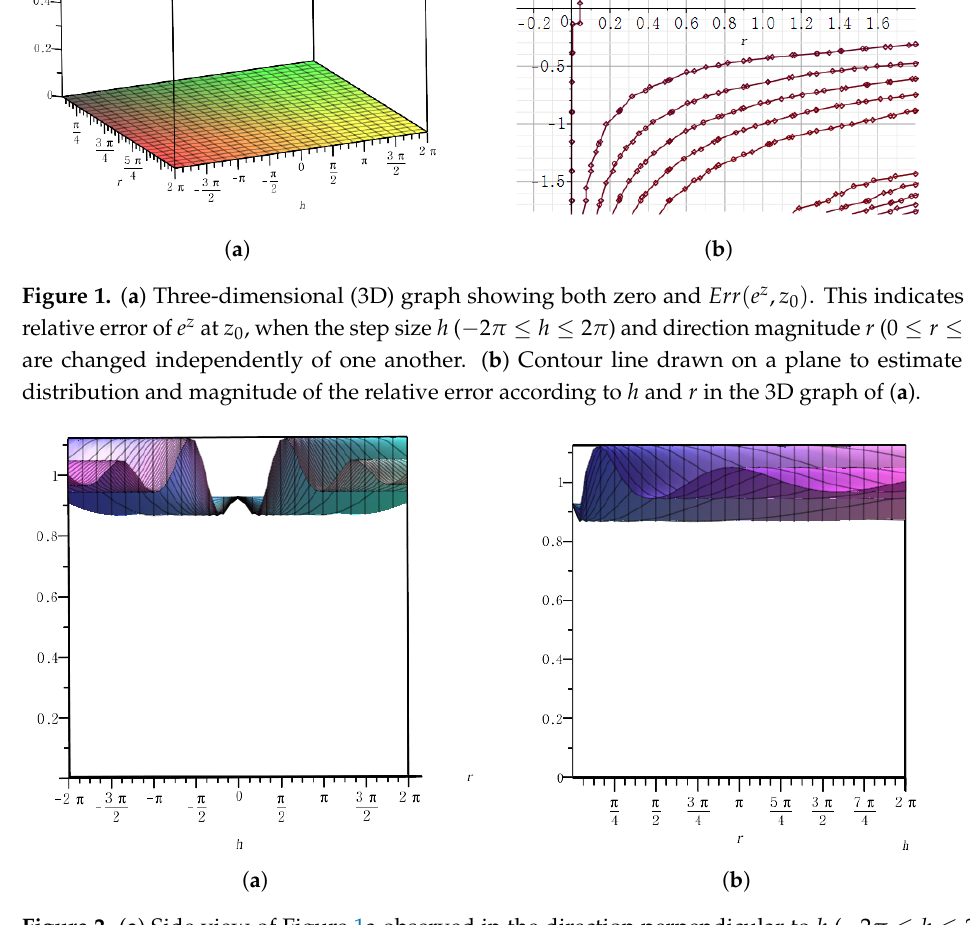
Figure 2. ( a ) Side view of Figure 1a observed in the direction perpendicular to h ( − 2 π ≤ h ≤ 2 π ). ( b ) Side view of Figure 1a observed in the direction perpendicular to r (0 ≤ r ≤ 2 π